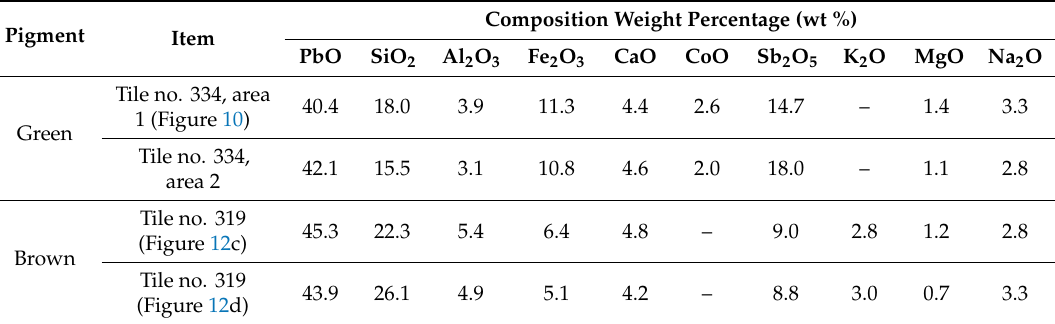
Figure 10. Microscopic images of the green pigment (tile no. 334, Type A): ( a ) view of green pigment surface (multifocal LM); ( b ) general SEM image of the pigment (bright dots at the upper part of sample, BSE mode); ( c ) the pigment particles (bright dots, BSE mode); and ( d ) area of the cracked white glaze matrix with a few bright pigment particles (BSE mode). Table 2. SEM-EDS chemical analysis of the Type A tile pigment matrix.